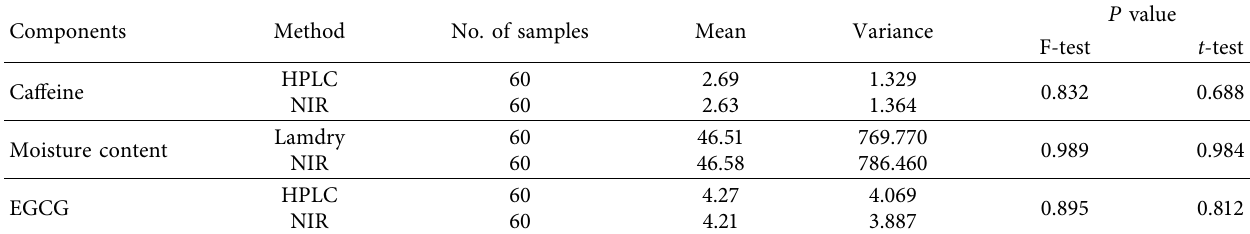
Table 7: Results of robustness checks.